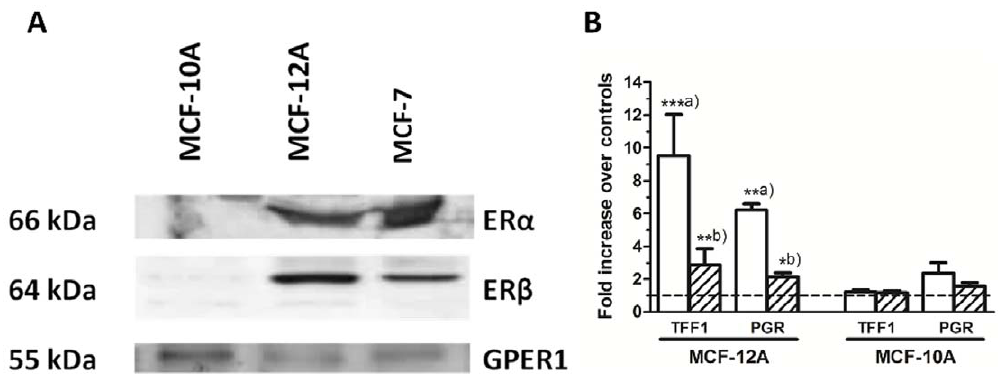
Figure 1. Receptor status and activation of ER a , ER b and GPER in MCF-12A and MCF-10A cells. A . ER a , ER b and GPER expression detected by immunoblotting. B . Regulation of ER-target genes. White bars represent treatment with 1 nM E2. Hatched white bars show the effects of E2 in combination with ICI 182,780 (1 m M). Horizontal dashed line corresponds to the negative controls (0.5% ethanol), set to 1. Data are from 3 independent experiments and error bars are mean 6 SEM. **a) shows statistically significant differences (p , 0.01) between treatments and controls. **b) (p , 0.01) and *b) (p , 0.05) highlight significant differences between treatments with E2 tested individually and treatments with E2 combined with ICI 182,780.